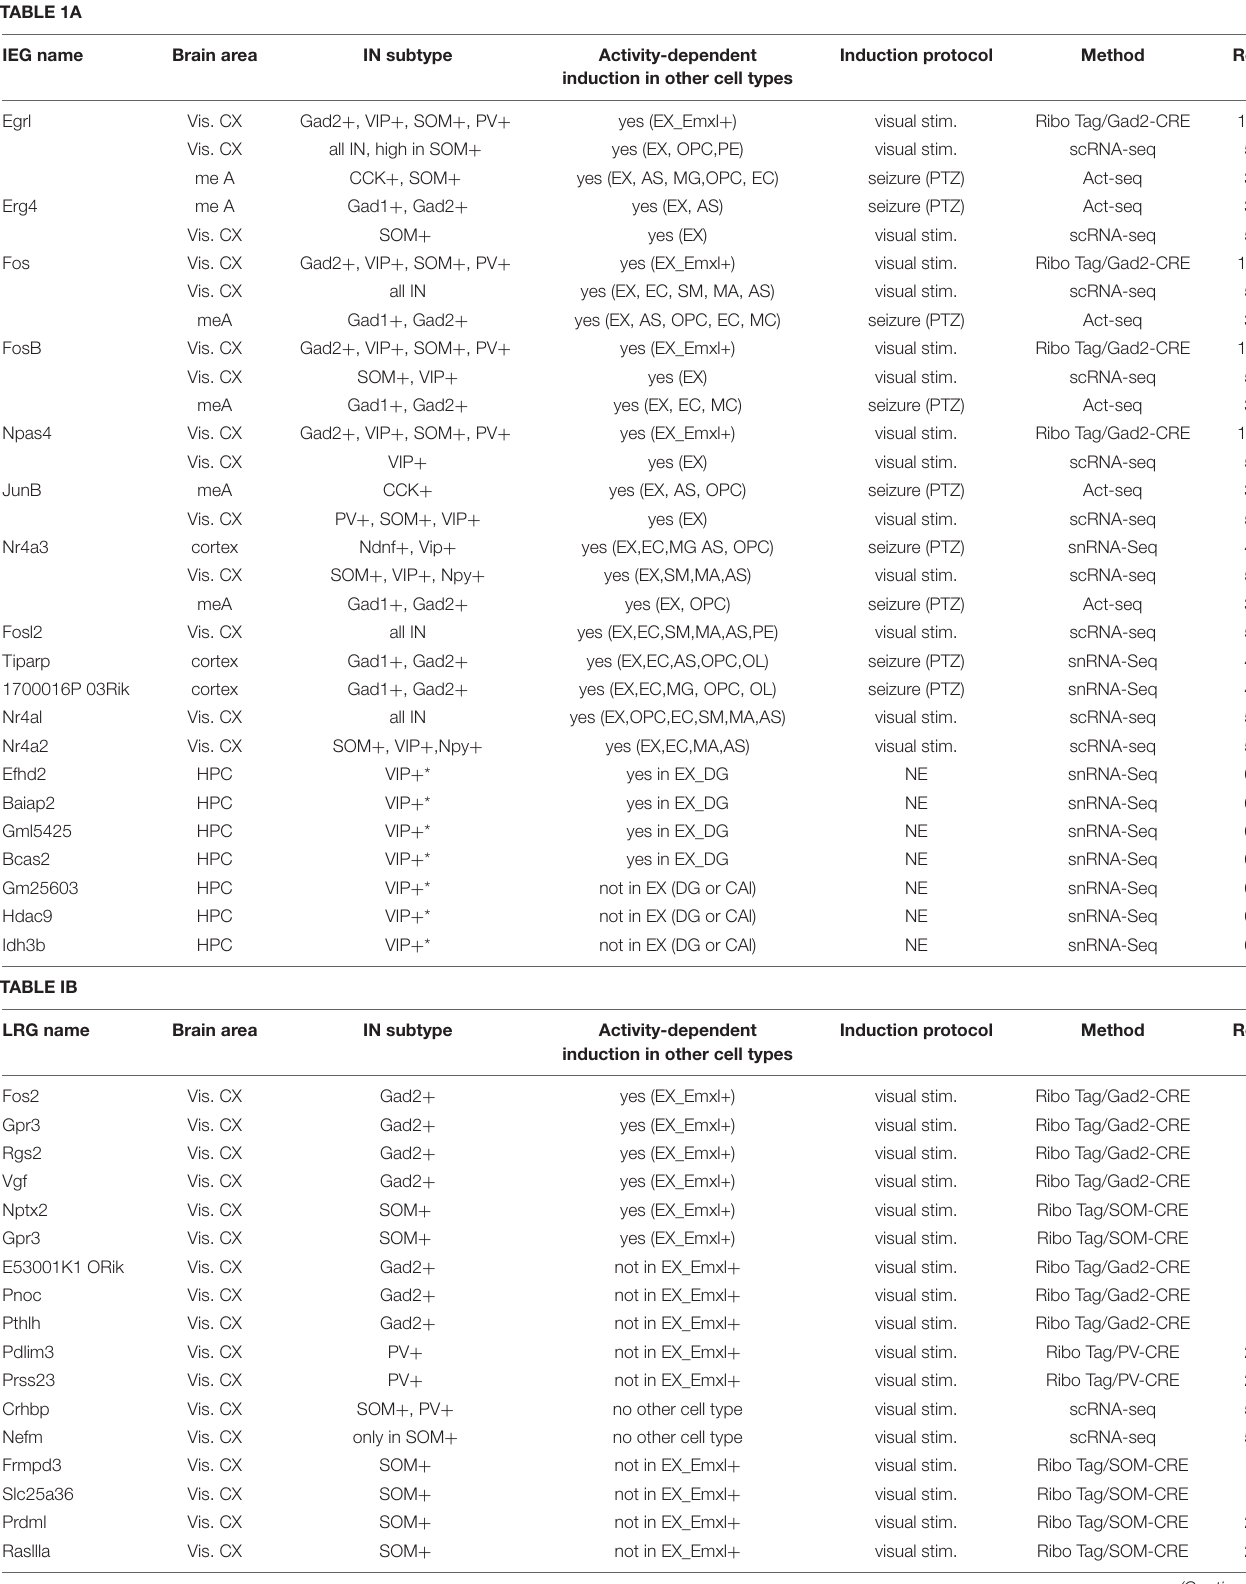
TABLE 1 | Examples of IEGs and LRGs induced in inhibitory